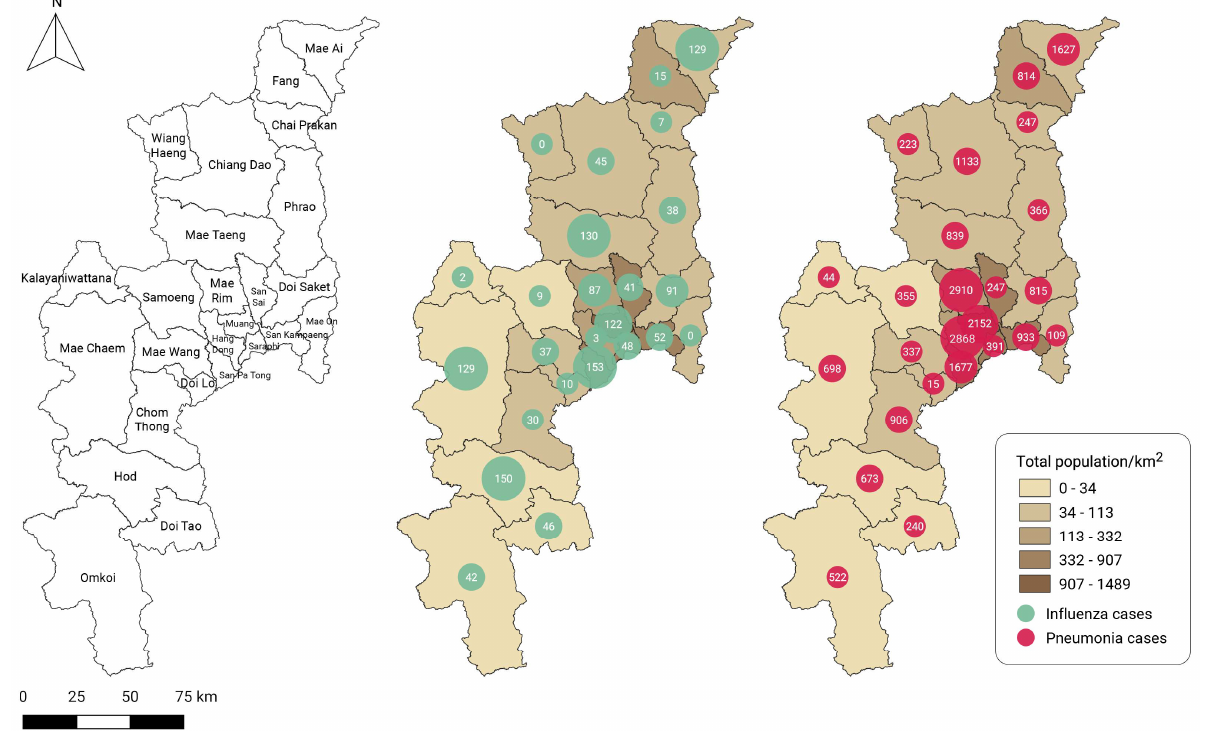
Figure 4. District administrative areas of Chiang Mai province ( left ). Cumulative case reports by district for ( middle ) influenza and ( right ) pneumonia in Chiang Mai obtained from the Bureau of Epidemiology’s PM 2.5 health center data (HDC) database between July 2020 and June 2022.